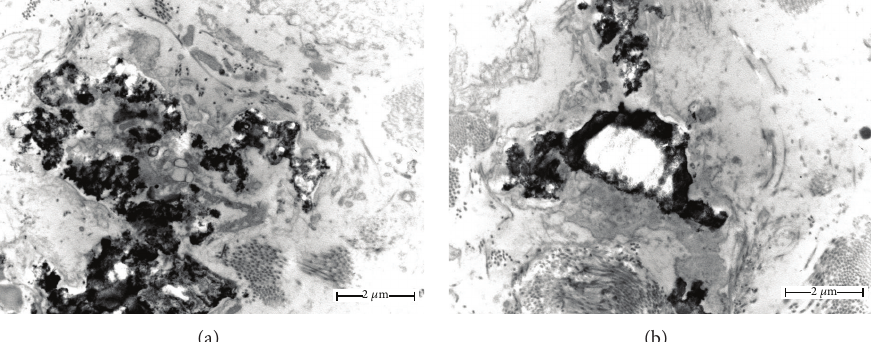
Figure 3: An ultrastructural view of the lesion obtained from the oral cavity. (a) Note the presence of electron-dense calcified bodies in the core of the elastic fibers with some calcifications resulting in ruptures. (b) Observe the presence of calcified material in the center of an elastic